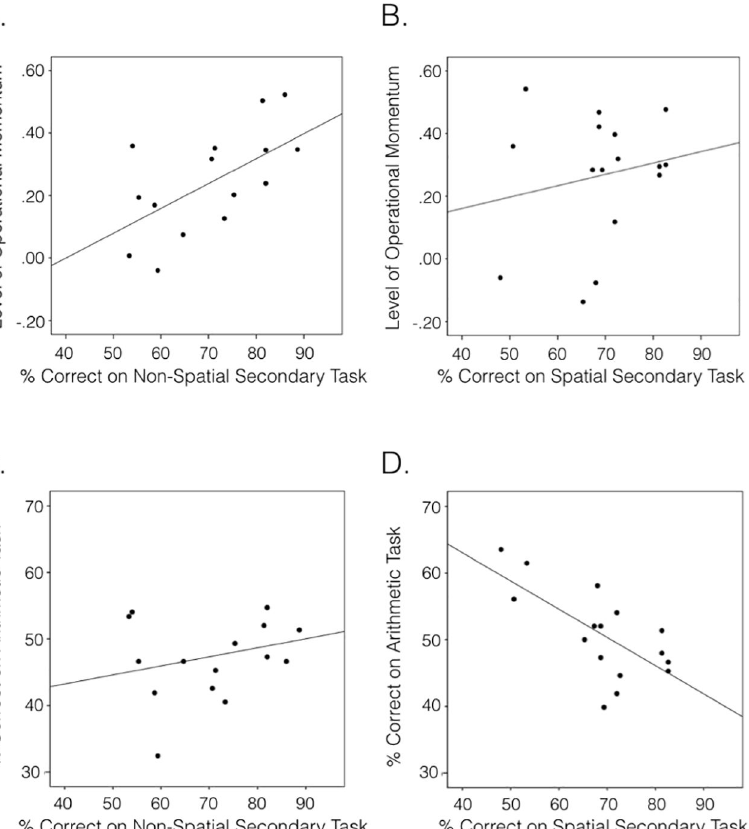
Figure 3. Panel A: The positive linear relation between overall amount of operational momentum exhibited by participants and their performance on a non-spatial secondary task, R 2 = .36. Panel B: The uncorrelated relation between overall amount of operational momentum exhibited by participants and their performance on a spatial secondary task, R 2 = .04. Panel C. The uncorrelated relation between accuracy for an arithmetic task and a non-spatial secondary task, R 2 = .07. Panel D. The negative linear relation between accuracy for an arithmetic task and a spatial secondary task, R 2 =